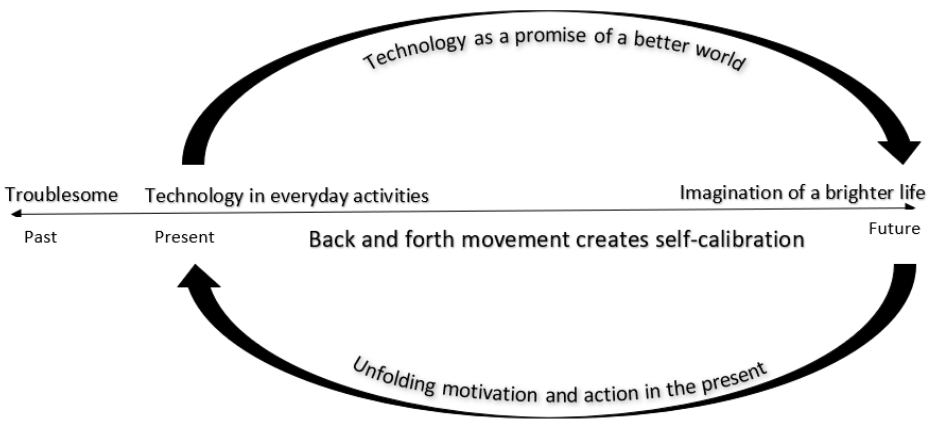
Figure 1. Continuum of the other-oriented hope related to technology.